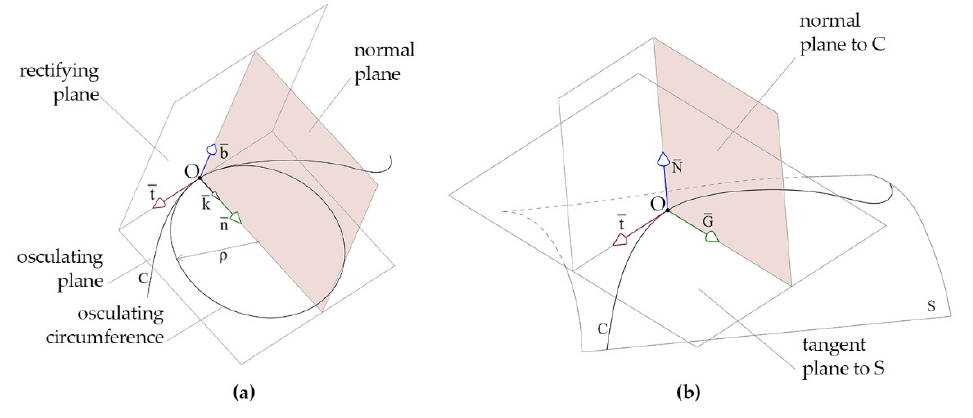
Figure 3. Frenet trihedron ( a ) and Darboux trihedron ( b